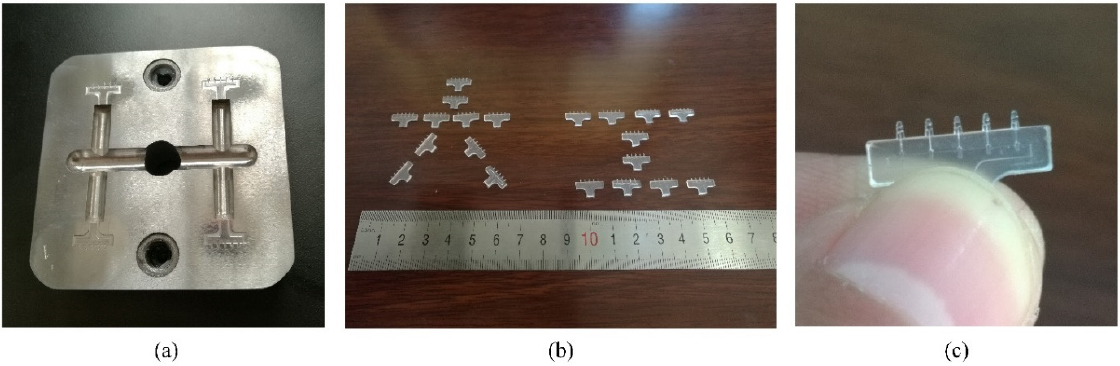
Figure 15. Actual mold and product. ( a ) Injection molding mold; ( b ) eventual product; ( c ) single microneedle array product.